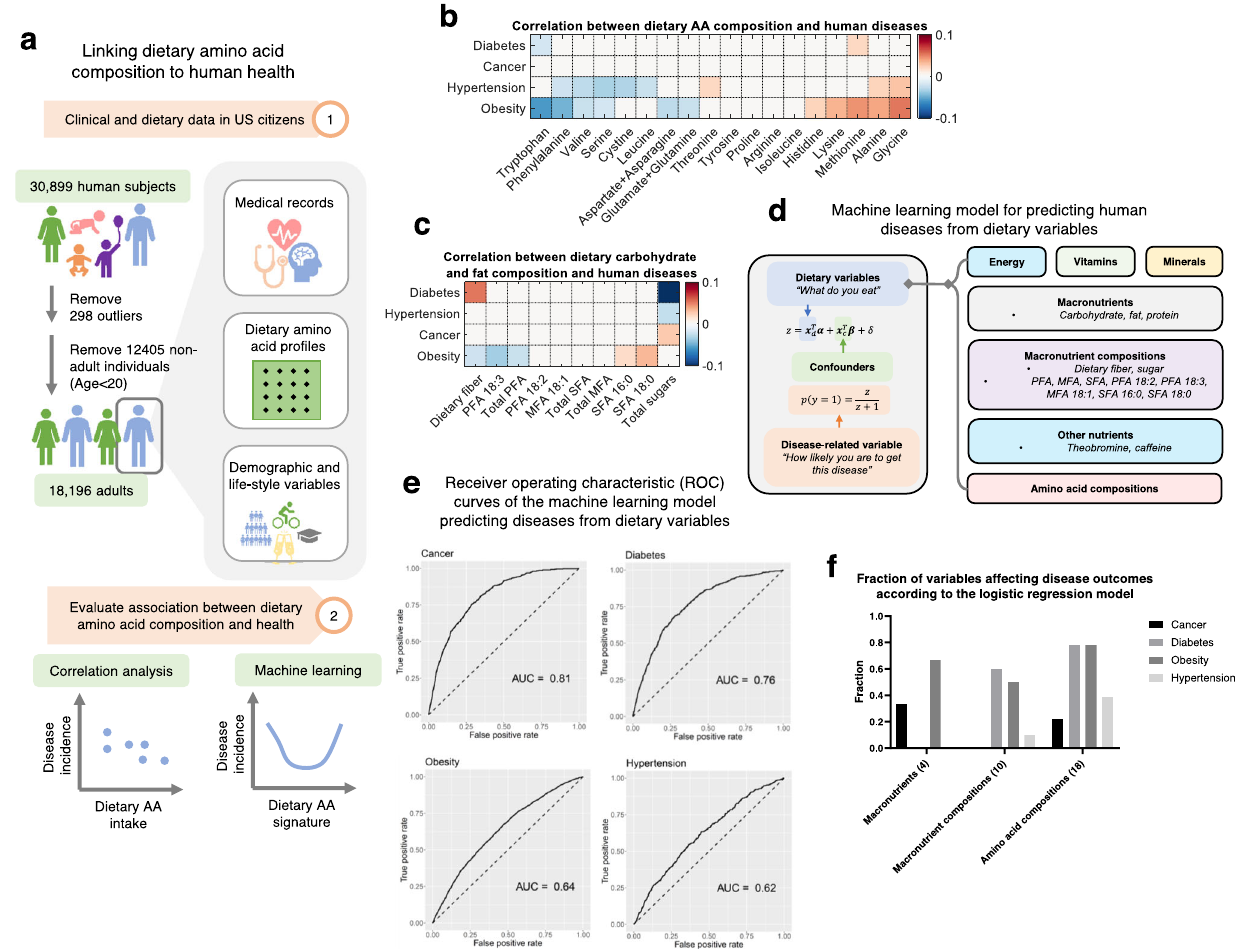
Fig. 4 | Amino acid intake is predictive of human health. a Work fl ow for the analysis of association between dietary amino acid intake and human health. Ima- ges used with permission from Microsoft. b Partial Spearman correlation between prevalenceofhumandiseasesanddietaryintakeofaminoacids. c PartialSpearman correlation between prevalence of human diseases and dietary intake of different types of carbohydrate and fat. d Framework of the machine learning model